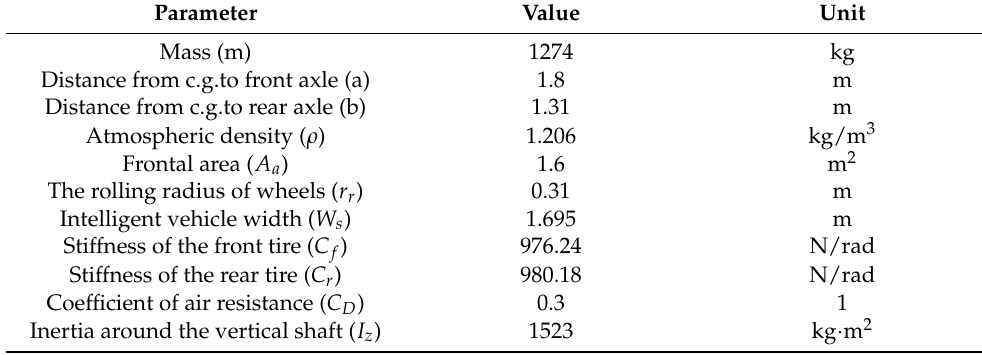
Coefficient of air resistance ( 𝐶 𝐷 ) Inertia around the vertical shaft ( 𝐼 𝑧 ) 1523 kg·m 2